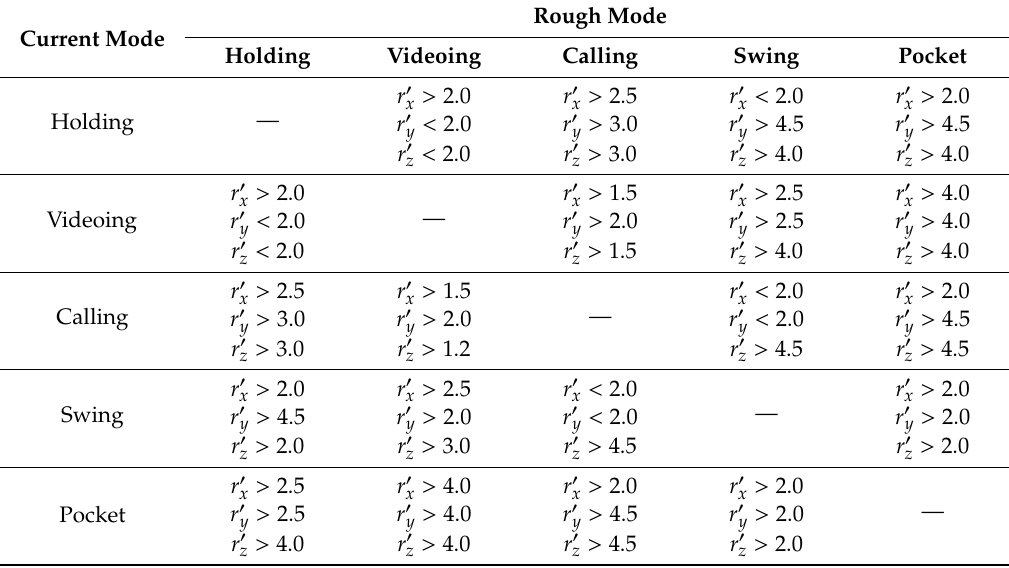
Table 1. The thresholds of angular velocities triggering the TRANS